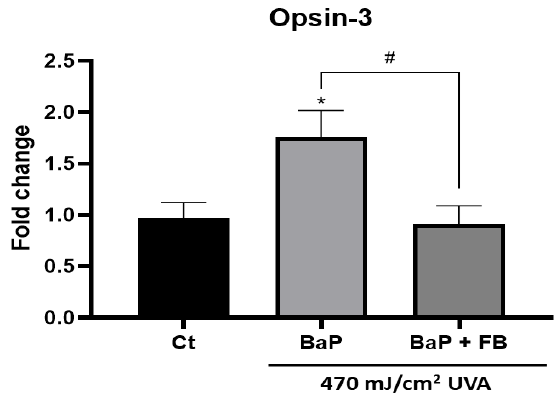
Figure 8. Opsin-3 expression in non-irradiated B16-F10 cells and cells loaded with BaP, FB and exposed to UVA light. Cells were treated with BaP and BaP + FB and subsequently irradiated with 470 mJ/cm 2 of UVA light. Opsin-3 was quantified 24 h after irradiation through RT-PCR. Opsin-3 expression appeared to increase in cells treated with BaP, whereas FB treatment diminished this expression reaching control values. ( n = 3, one-way ANOVA compared to Ct cells *: p < 0.05 and n = 3, t -test compared to BaP treated cells #: p < 0.05).